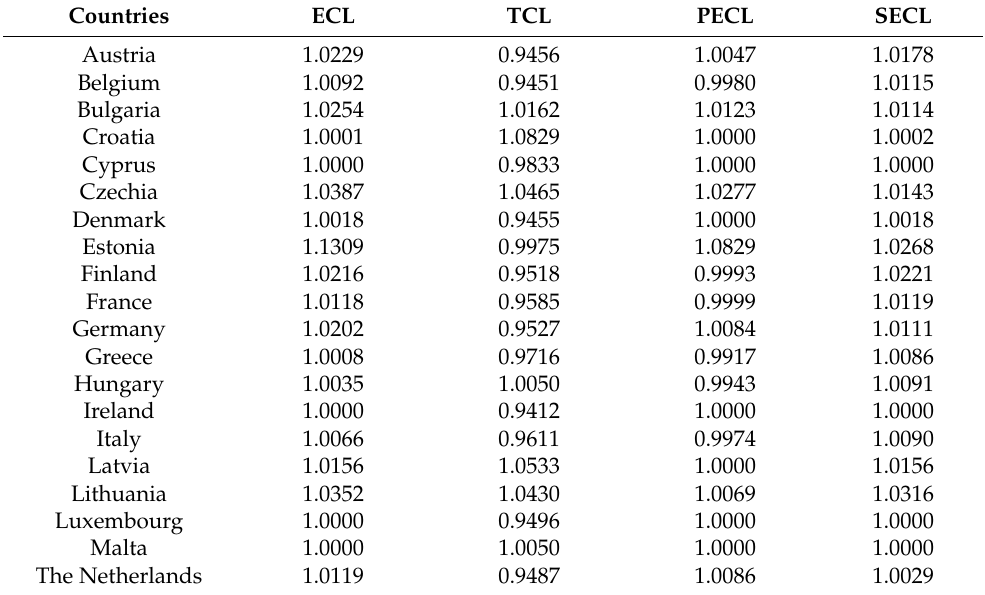
Table A2. Annual means, for the entire period, of Malmquist–Luenberger productivity index compo- nents by